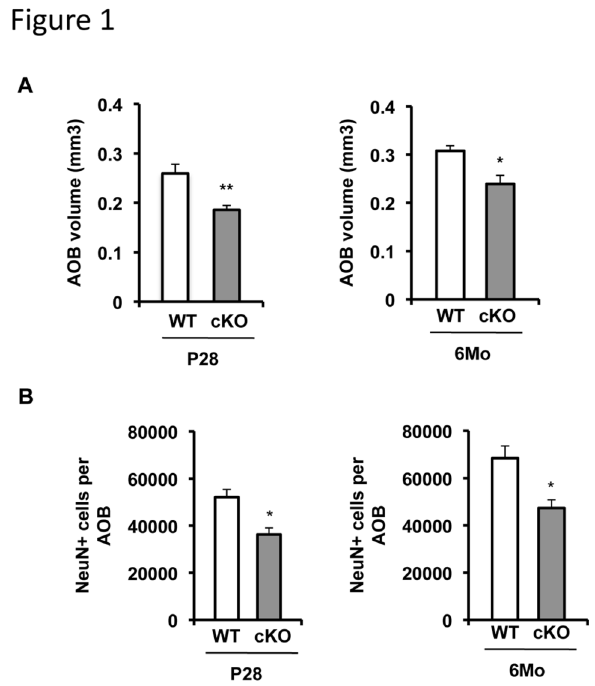
Figure 1. ERK5 cKO mice have smaller accessory olfactory bulb (AOB). A , ERK5 deletion results in a smaller AOB at P28 and 6 months of age. B , There are fewer NeuN + neurons in the AOB of ERK5 cKO mice at P28 and 6